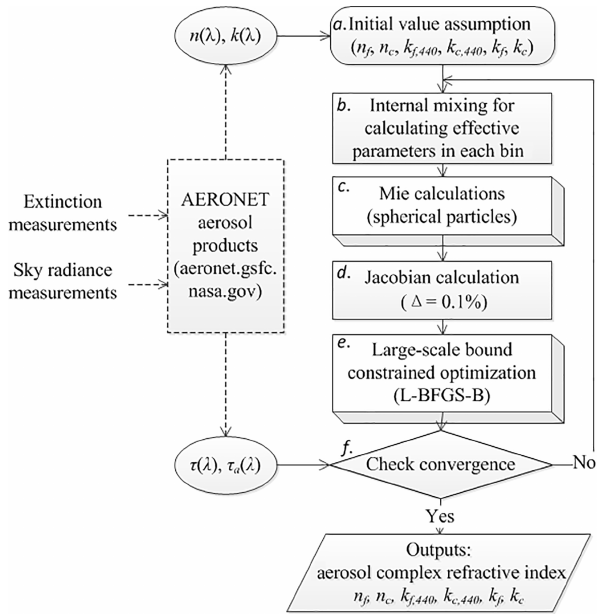
Figure 2. The flowchart of the fine and coarse mode CRI estimation